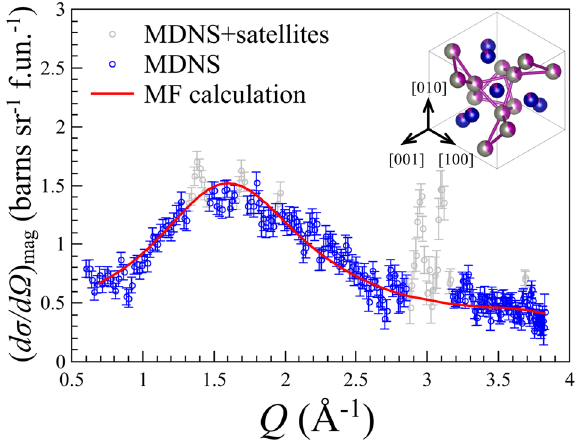
Fig. 2 Neutron scattering from Co 7 Zn 7 Mn 6 and mean- fi eld model. Magnetic scattering measured at D7 from Co 7 Zn 7 Mn 6 powder at T = 2 K. The entire pro fi le is shown by blue and light grey symbols. The latter correspond to magnetic Bragg peaks, and are omitted for the MF J nn model fi tting described in the text (red line). Error bars indicate the statistical error. Inset: Sketch showing the J nn interaction (purple bonds) between nearest-neighbours on the 12 d Fig. 2 reveal the volume of MDNS falls monotonically with increasing T , and that it persists for high T > T c .